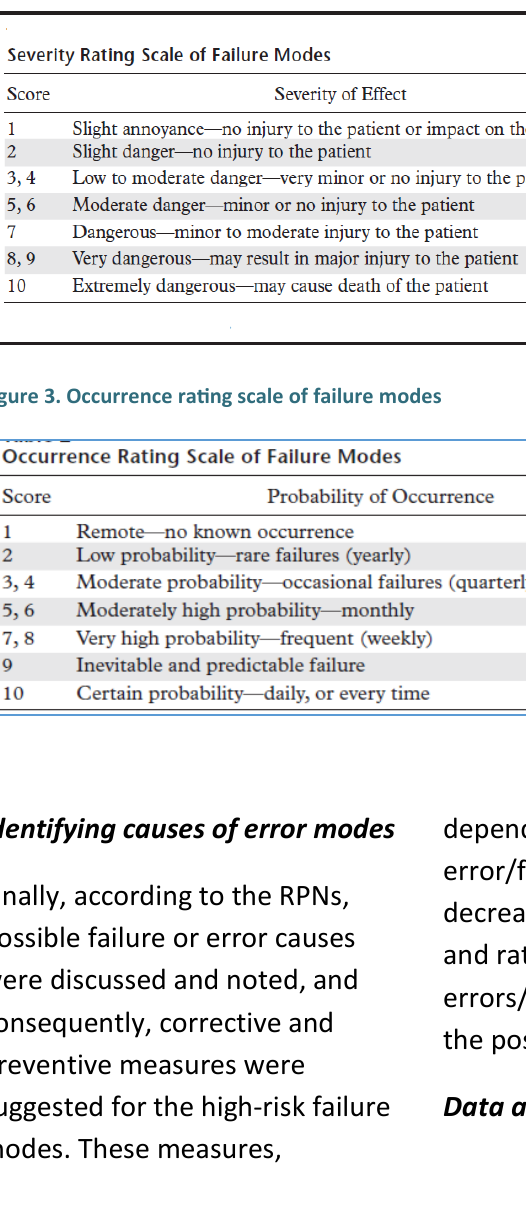
Figure 1 . Severity ra�ng scale of failure modes